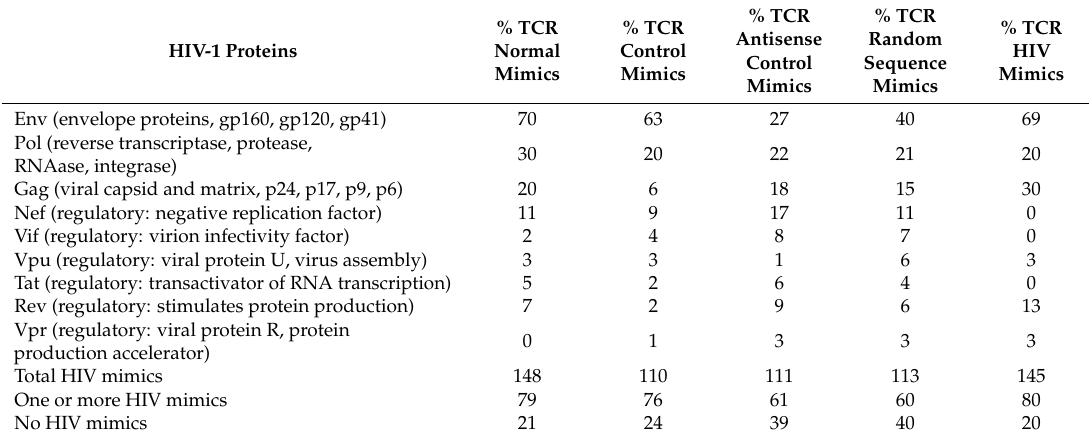
Table 3. Frequency with which HIV TCR mimic HIV proteins. See Figure 2 for